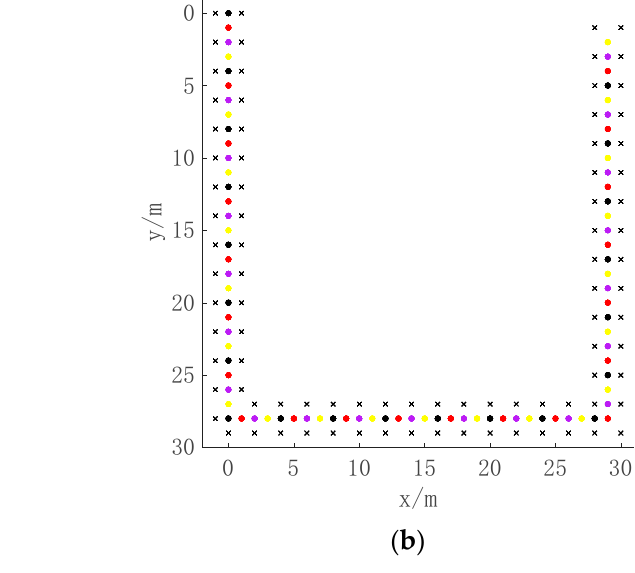
Figure 6. ( a ) Testbed plan; ( b ) coordinates of TPs and RPs.